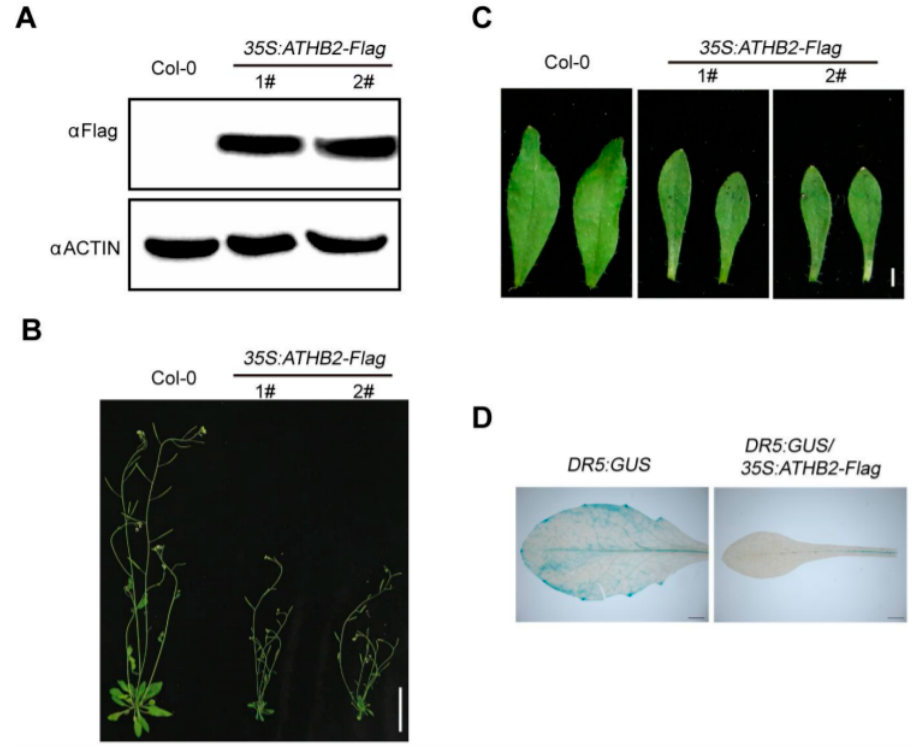
Figure 2. Morphological phenotype of 35S:ATHB2-FLAG transgenic lines. ( A ) Immunoblotting analysis showing the ATHB2-FLAG protein levels in the 35S:ATHB2-FLAG transgenic plants. The 6 day old seedlings of Col-0 and 35S:ATHB2-FLAG transgenic plants were harvested for immunoblotting analysis. ACTIN was used as a loading control. 1# and 2# represent two independent transgenic lines of 35S:ATHB2-FLAG. The data are representative of three independent experiments. ( B and C ) Overview of the Col-0 and 35S:ATHB2-FLAG transgenic lines at the adult stage. ( B ) Scale bars, 4cm. Leaf morphology of the Col-0 and 35S:ATHB2-FLAG transgenic lines at the adult stage. ( C ) Scale bars, 2 mm. The 4-week-old 35S:ATHB2-FLAG transgenic plants grown under normal growth conditions were used for phenotypic analyses. ( B and C ) Two independent transgenic lines were used for phenotype observation. The images are representative of three independent experiments. ( D ) Expression patterns of DR5:GUS in the leaves of DR5:GUS and DR5:GUS/35S:ATHB2-FLAG plants . The leaves of 3-week-old DR5:GUS and DR5:GUS/35S:ATHB2-FLAG plants were used for GUS activity analyses. The images are representative of three independent experiments.